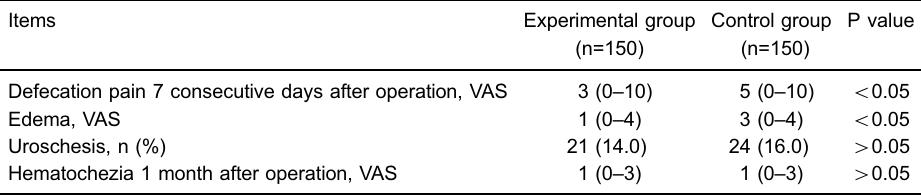
Table 4. Comparison of postoperative complications between the two